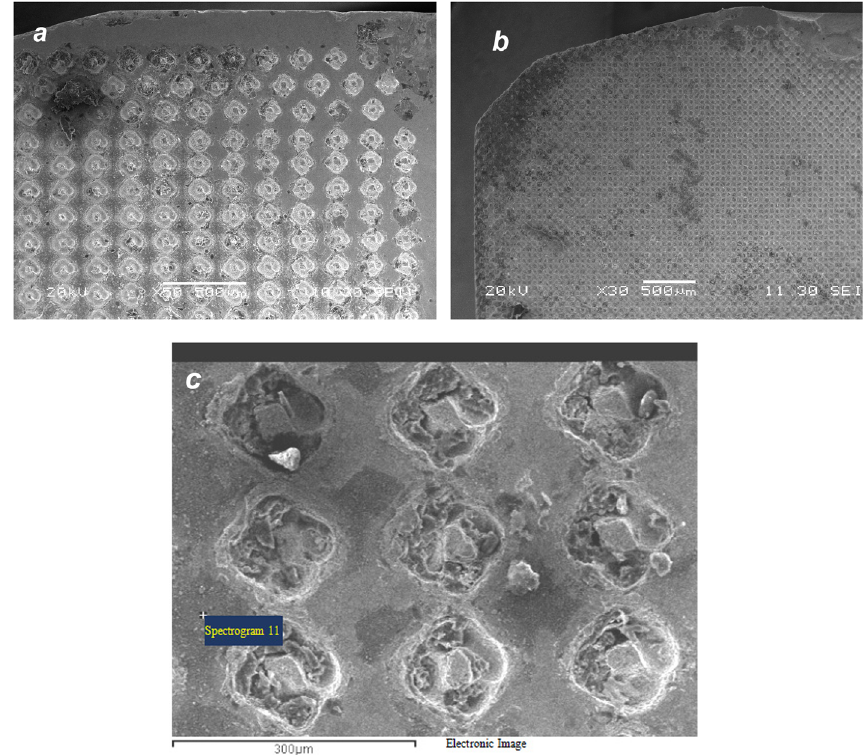
Figure 8: Micromorphology of pit micro - textured tool after cutting: ( a ) parallel, ( b ) perpendicular, ( c ) magni fi ed view of ( b ) .